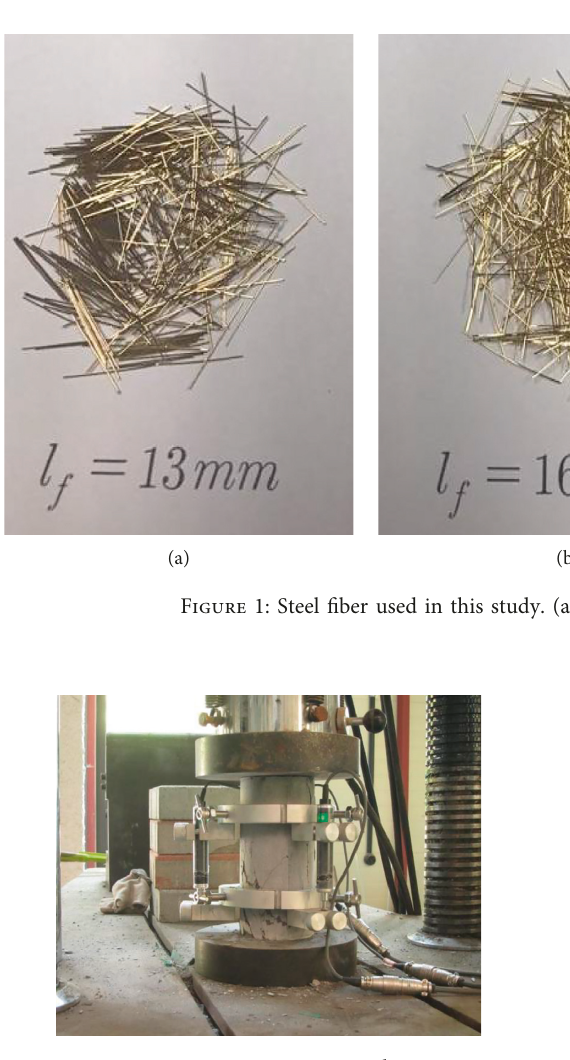
Figure 2: Compressive strength